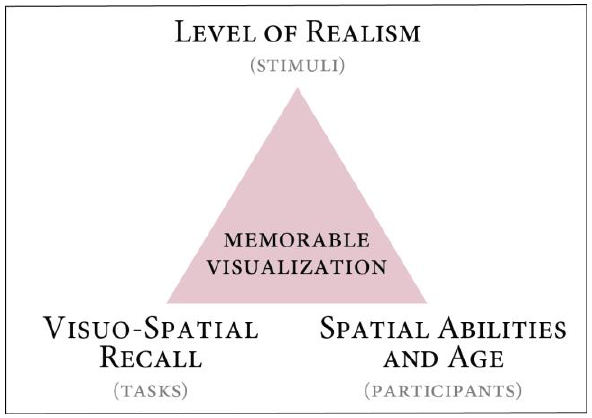
Figure 1. The broad conceptual design for experiments for testing the memorability of geovisualizations in our